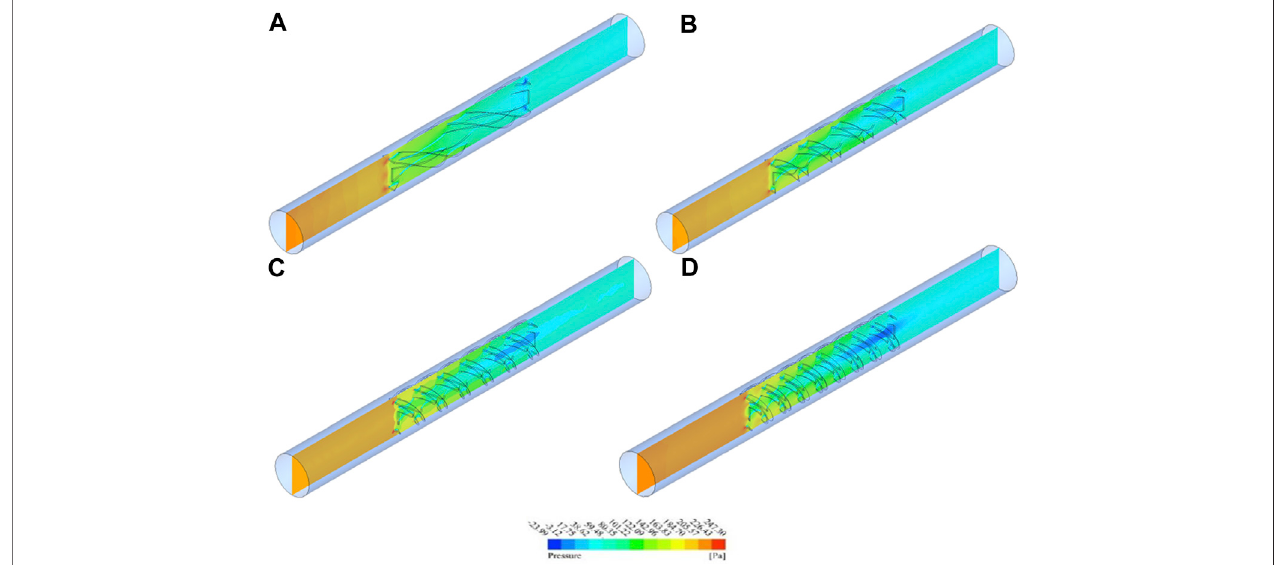
FIGURE 4 | The distribution of pressure fi eld at torsion ratios of (A) n (cid:1) 1, (B) n (cid:1) 2, (C) n (cid:1) 3, and (D) n (cid:1) 4.